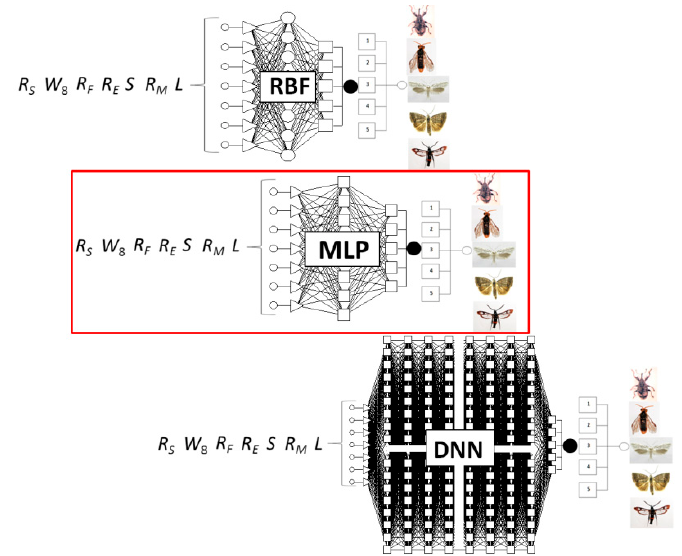
Figure 2. Structures of the generated RBF, MLP and DNN networks.